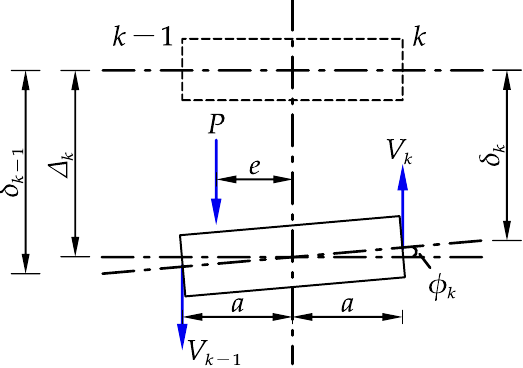
Figure 4. The free body diagram of the k th slab.